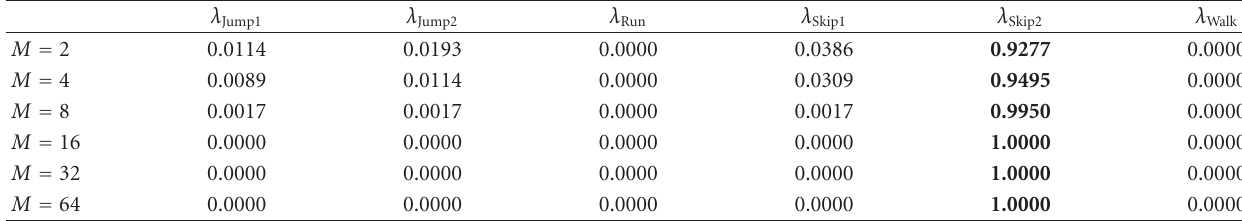
Table 2: Classification of two-footed skipping activity versus data segment